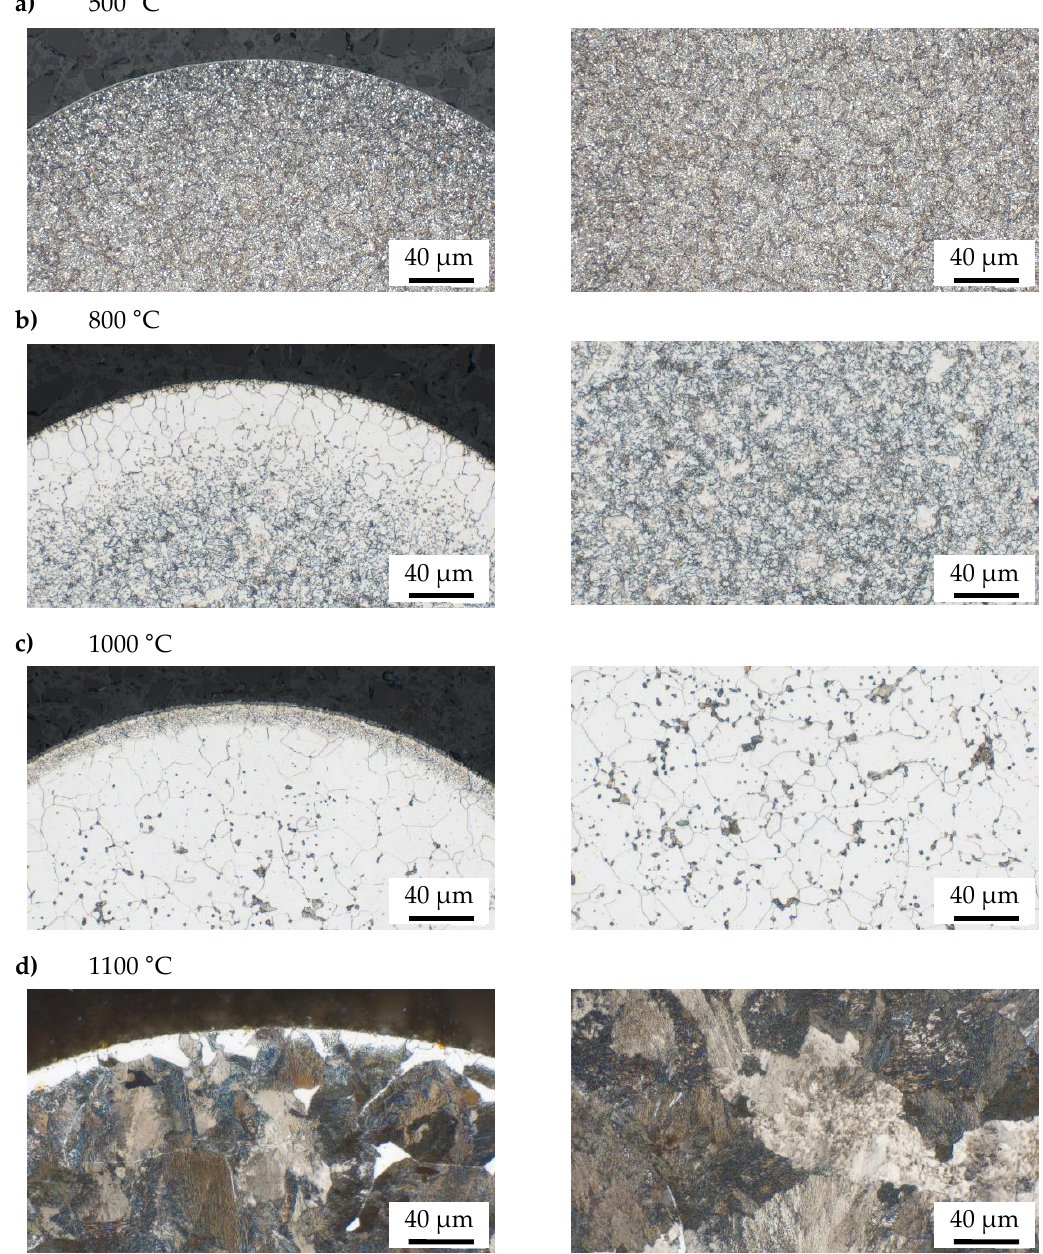
Figure 3. Microstructure of the microsamples near the surface ( left ) and in the middle of the sample ( right ) after the heat-treatment at ( a ) 500 °C, ( b ) 800 °C, ( c ) 1000 °C and ( d ) 1100 °C; etched 25 – 30 s in 3% alcoholic HNO 3 , equatorial cut.